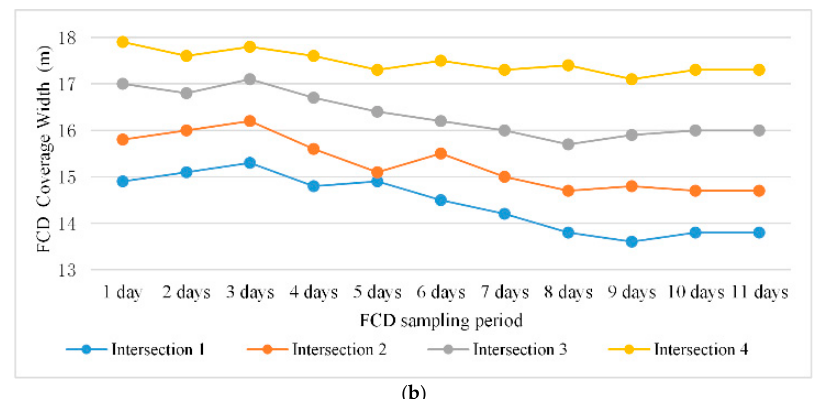
Figure 7. Results for different collection periods for FCD in the ( a ) middle segment of the road and ( b ) at the road intersection.